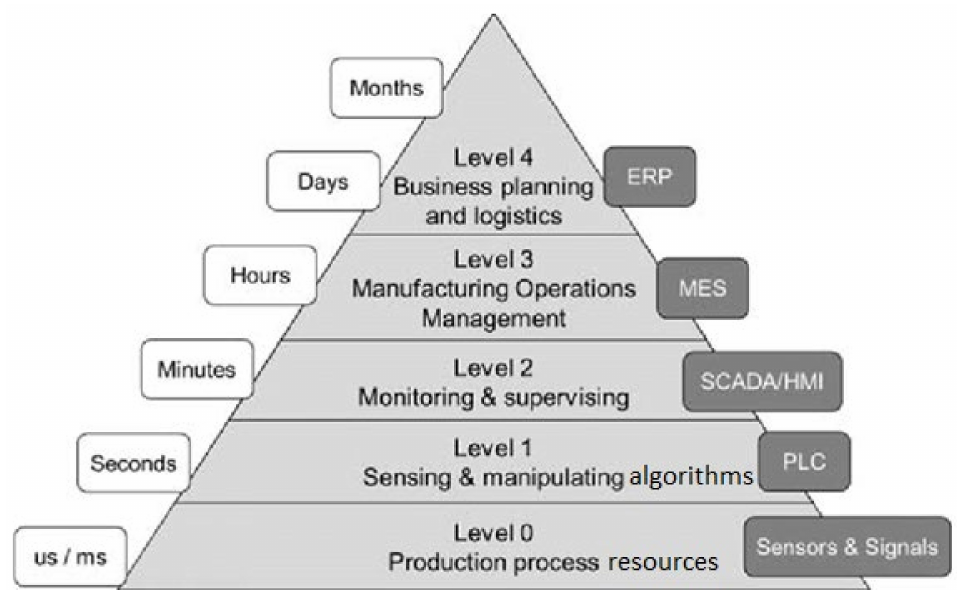
Figure 9. Automation hierarchy according to the ISA-95 model [38].